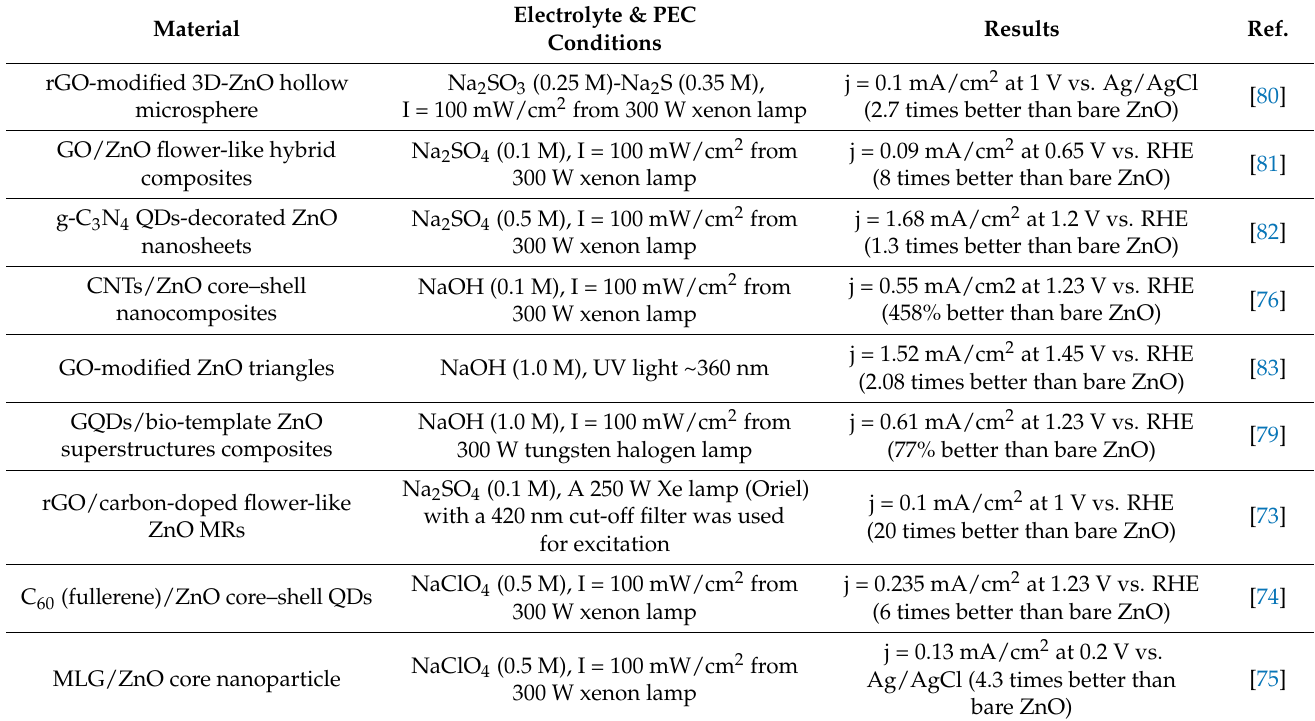
Table 3. PEC performance data of carbon-based material modified 3D-ZnO